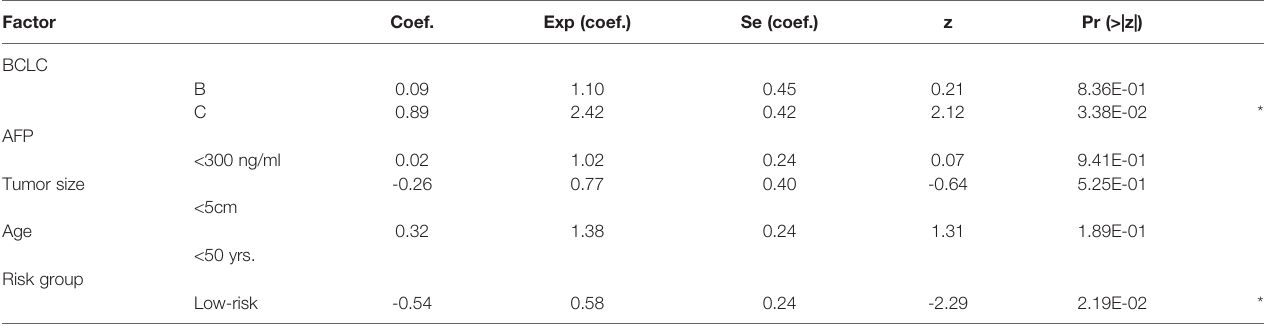
TABLE 2 | The coef fi cients and statistical signi fi cance of the risk strati fi cation and four prognostic factors in the multivariable model (validate (CPTAC) cohort). Factor Coef. Exp (coef.) Se (coef.)